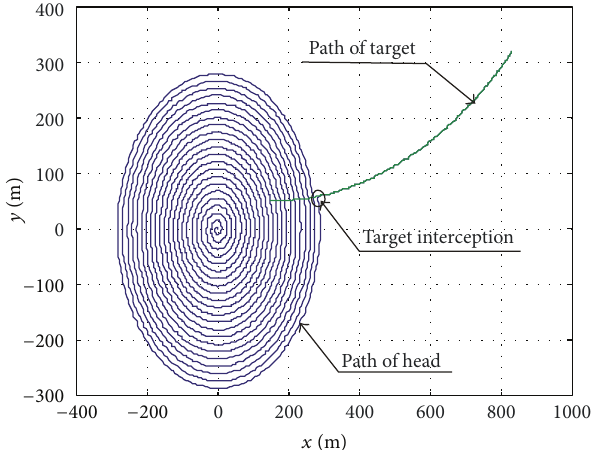
Figure 7: Path of movement of point 𝐻 and the target on the surface of the ground.